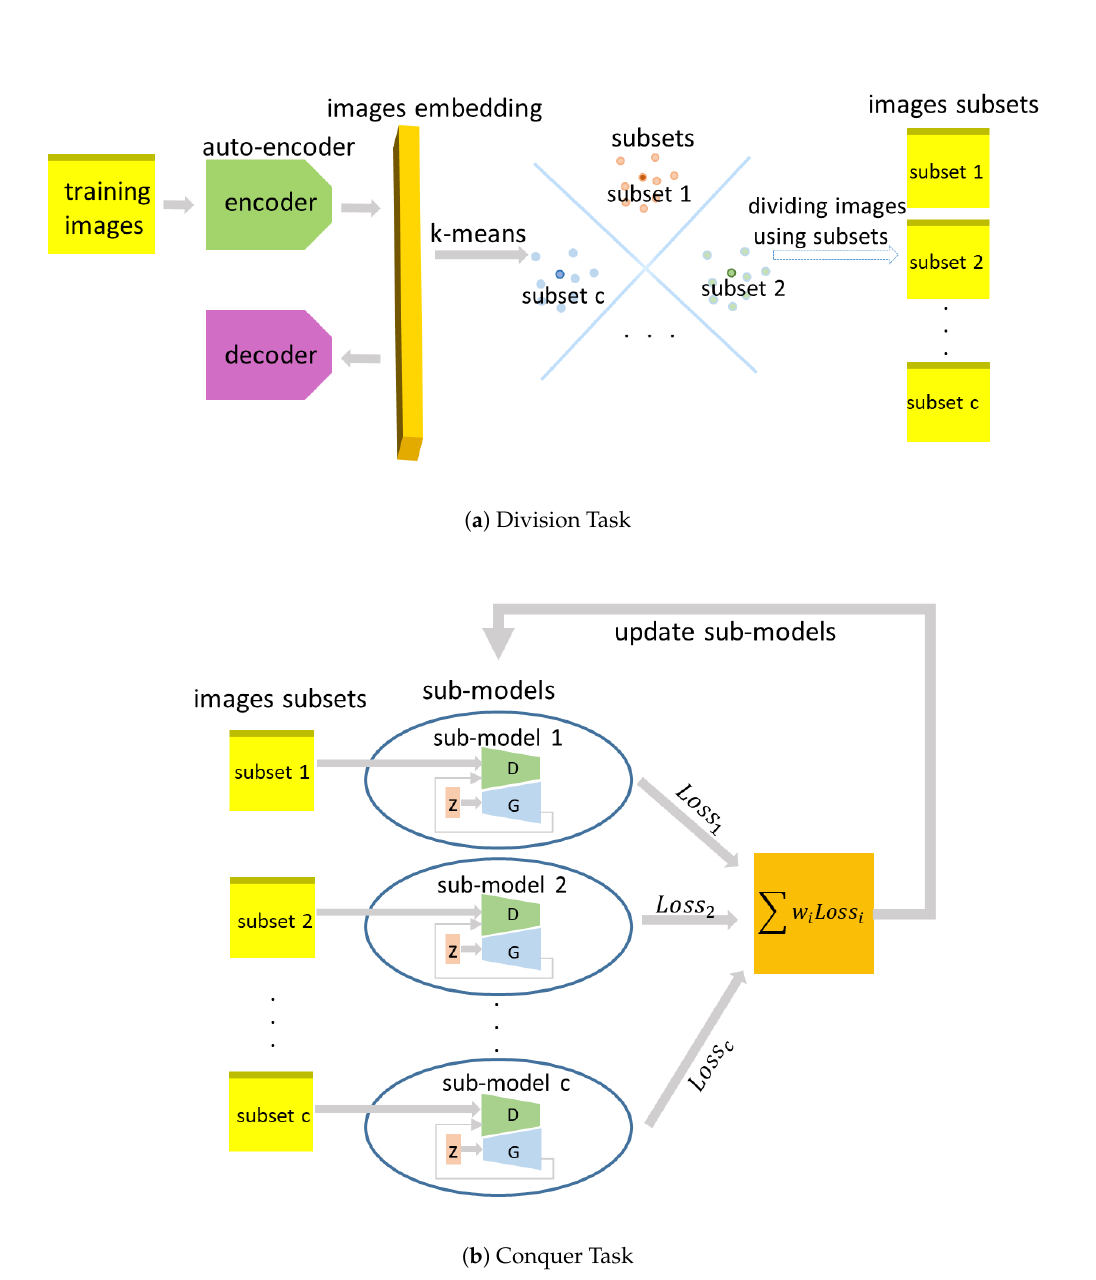
Figure 2. The structure of the DC-MMD-GANs. We train an auto-encoder and get embedding of training images from the output of encoder. K-means clusters on the embedding of auto-encoder into adaptive subsets. We divide the training images into subsets according to embedding subsets. Each sub-model is trained independently with different subsets. The master node computes the new weight-sum loss function and obtains precise empirical estimate based on output of